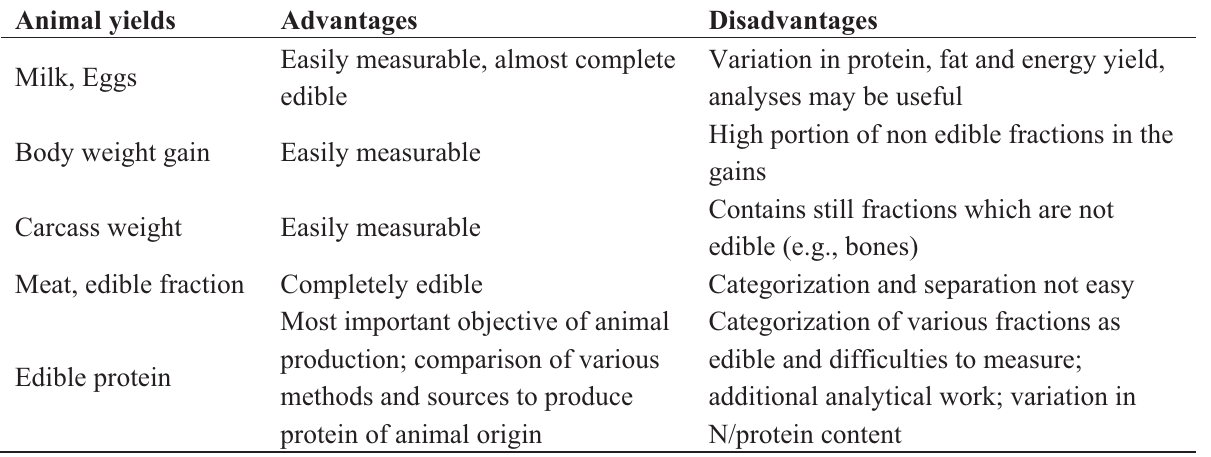
Table 9. Advantages and disadvantages of various outputs/endpoints of animal yields. Animal